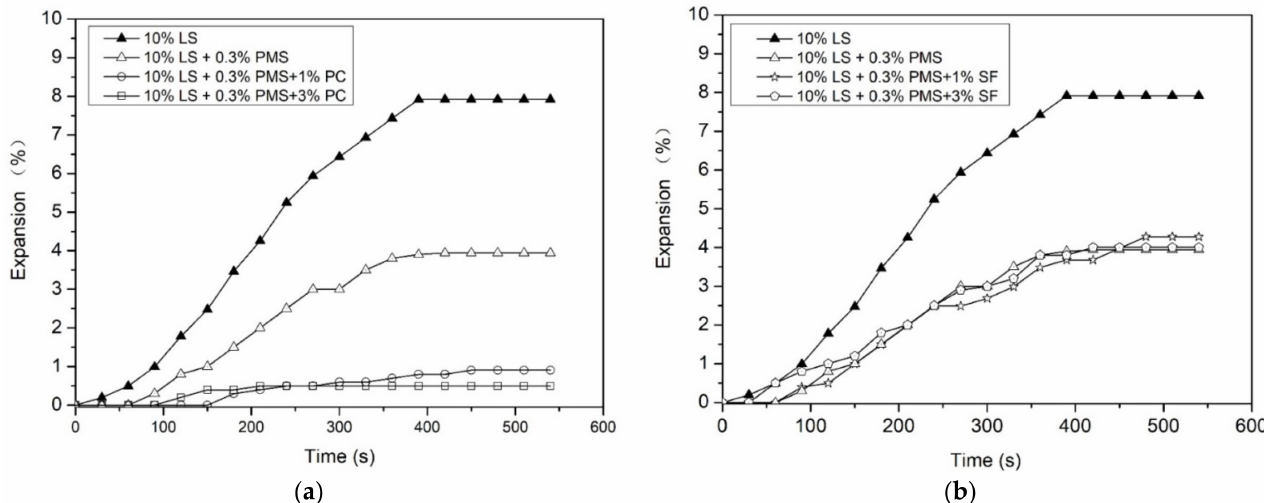
Figure 7. Expansion (before setting) of MAPC mortar samples with 10% limestone fines (LS) with or without defoaming treatment by the compound use of 0.3% polyether-modified silicone (PMS) defoamer and ( a ) Portland cement (PC); ( b ) silica fume (SF) at dosage of 1% and 3% (by weight of